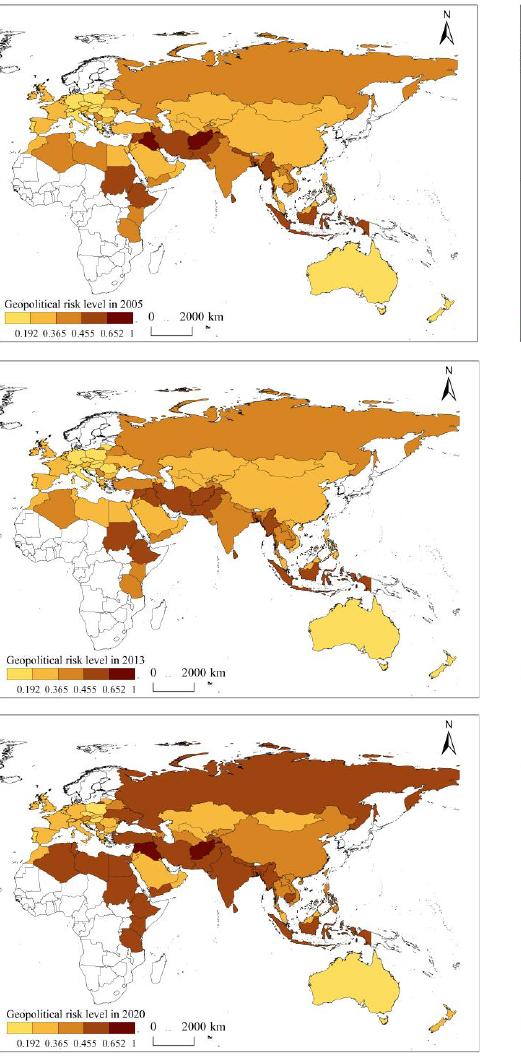
Figure 3. Spatial pattern of geopolitical risk in countries along the Belt and Road. Note: The map is drawn to the standard map of GS (2016) 1667 that comes from the standard map service system of the ministry of natural resources of the people’s Republic of China (http://bzdt.ch.mnr.gov.cn/index.html, accessed on 8 December 2022).